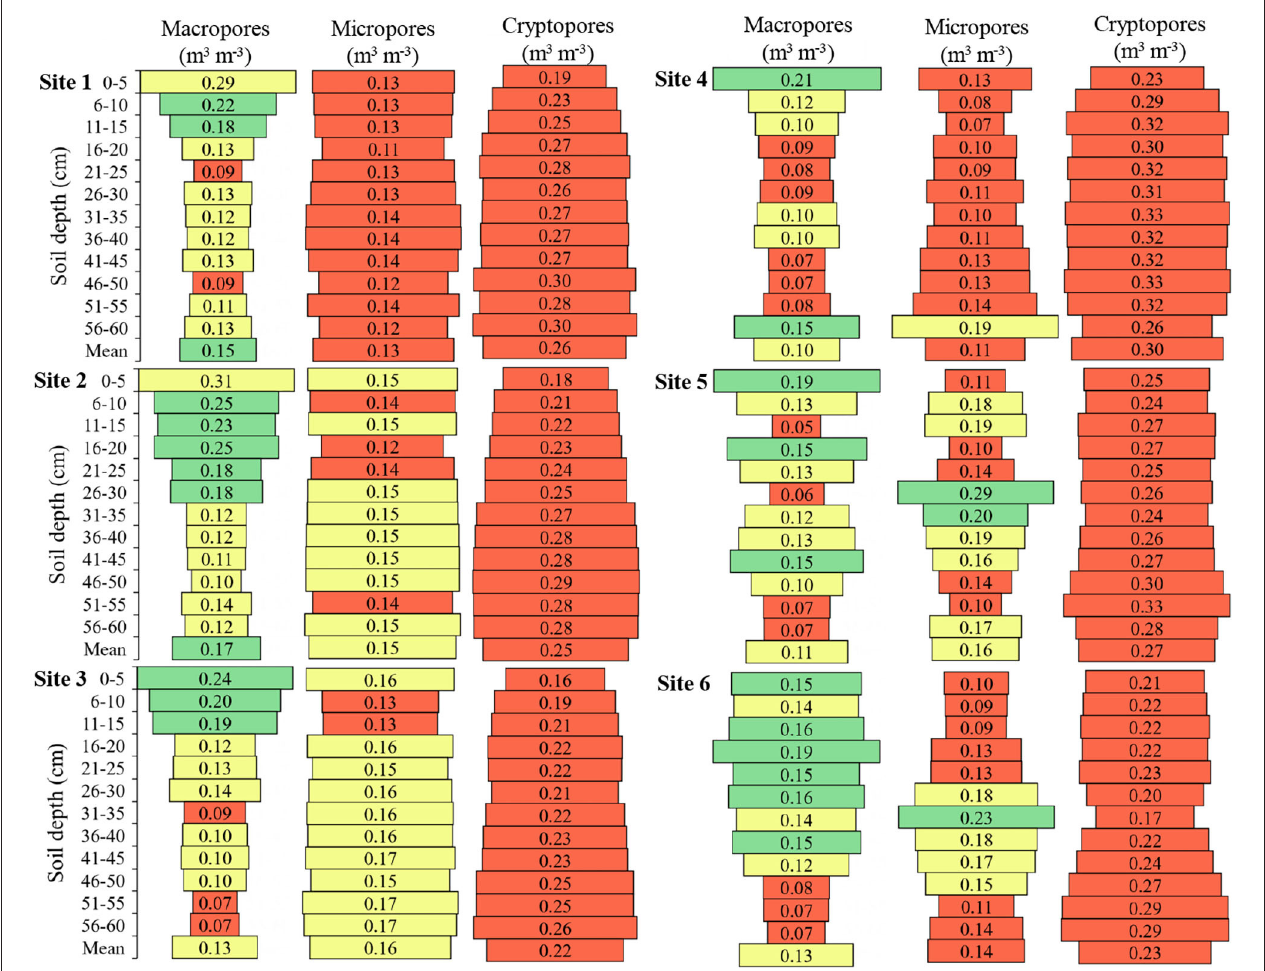
FIGURE 6 | Macropores ( > 0.05mm), micropores (0.05–0.0002mm), and cryptopores ( < 0.0002mm) of the soil in the six sites and at different soil depths. Green color: adequate values (Macropores 0.15–0.25; Micropores 0.20–0.30; Cryptopores ≤ 0.10); Yellow color: intermediate values (Macropores 0.10–0.14 or > 0.25; Micropores 0.15–0.19 or > 0.30; Cryptopores 0.10–0.15); Red color: inadequate values (Macropores < 0.10; Micropores < 0.15; Cryptopores > 0.15). Adapted from Reynolds et al. (2002) and Reynolds et al.